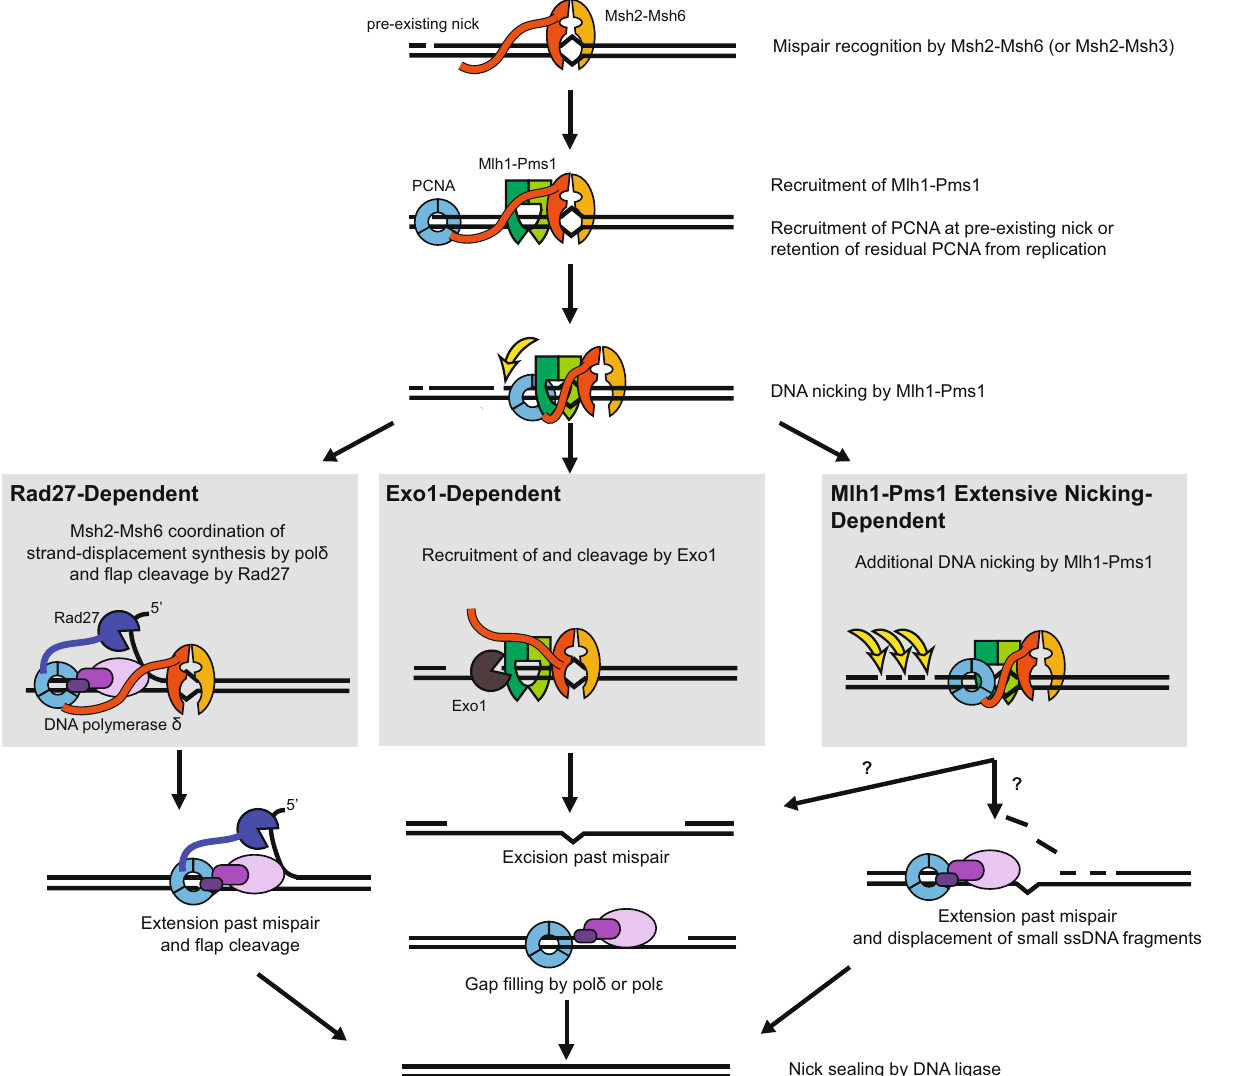
Fig. 6 Model for different MMR excision-resynthesis pathways. After mispair recognition by Msh2-Msh6 (or Msh2-Msh3) and recruitment of Mlh1- Pms1, a repair can be initiated by several pathways. In the well-understood Exo1-dependent pathway, recruitment of Exo1 by Msh2-Msh6 and/or Mlh1- Pms1 allows for 5 ’– >3 ’ resection of the nicked strand past the mispair to generate a gap. In the Rad27-dependent pathway, strand-displacement synthesis from a nick by DNA polymerase δ and 5 ’ fl ap cleavage by Rad27 is coordinated by Msh2-Msh6, likely through shared interactions with PCNA. In both of these pathways, the nicks could be pre-existing or could be made by the Mlh1-Pms1 endonuclease. The less well-understood Exo1-independent and Rad27- independent pathways are hypersensitive to reduced activation of the Mlh1-Pms1 endonuclease, suggesting a role for additional rounds of nicking by Mlh1- Pms1. Additional nicking could generate a gap, equivalent to the Exo1-dependent pathway, or small fragments that can readily be displaced by the strand- displacement synthesis in the absence of